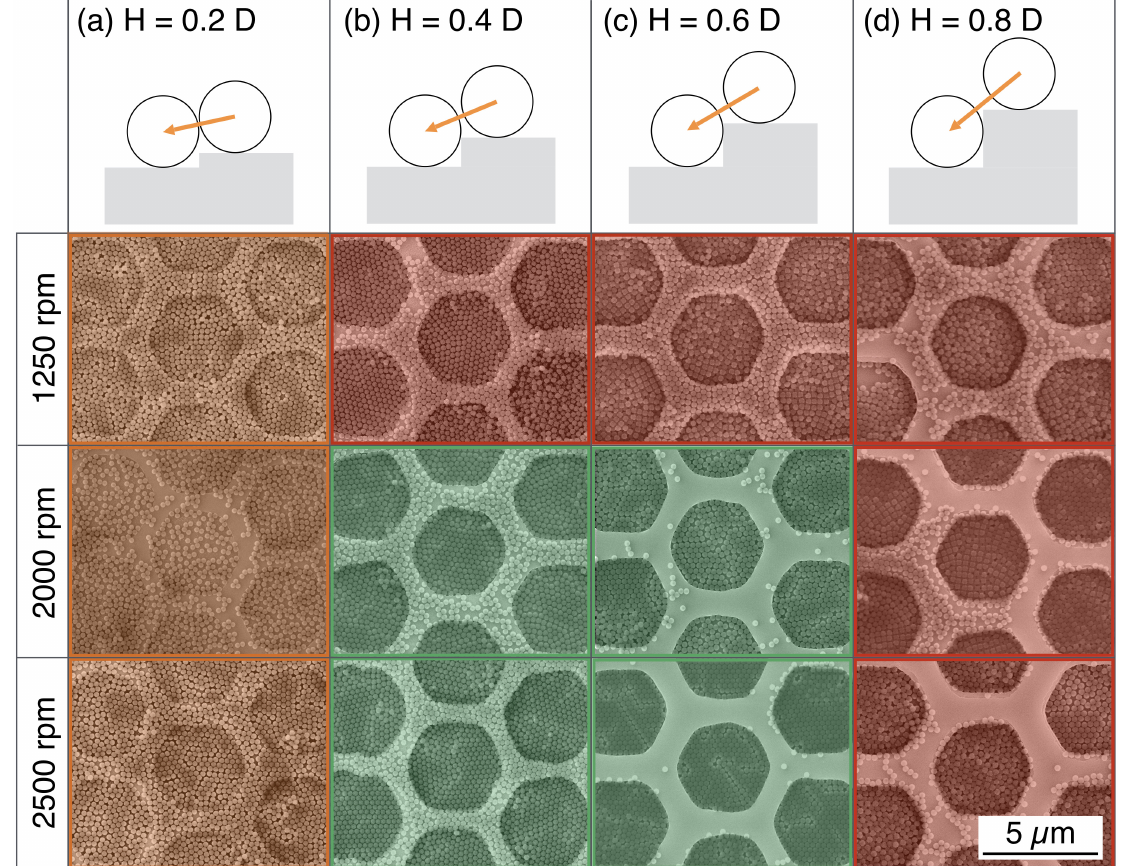
Figure 3. Tabular comparison of the SEM images of NSs assemblies inside hexagonal templates. The height of the confining wall varies along the columns, column ( a ) H = 0.2 · D, column ( b ) H = 0.4 · D, column ( c ) H = 0.6 · D and column ( d ) H = 0.8 · D. The spin-coating speed is varied in the rows from 1250rpm to 2500rpm. The SEM images highlighted in red and orange refer to unsuitable confinement conditions, whereas those coloured in green display suitable